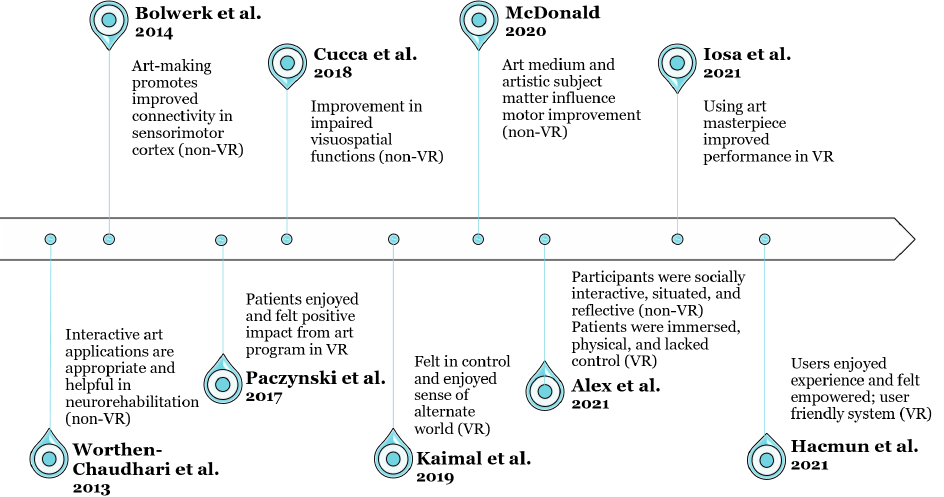
Figure 3. Timeline of study